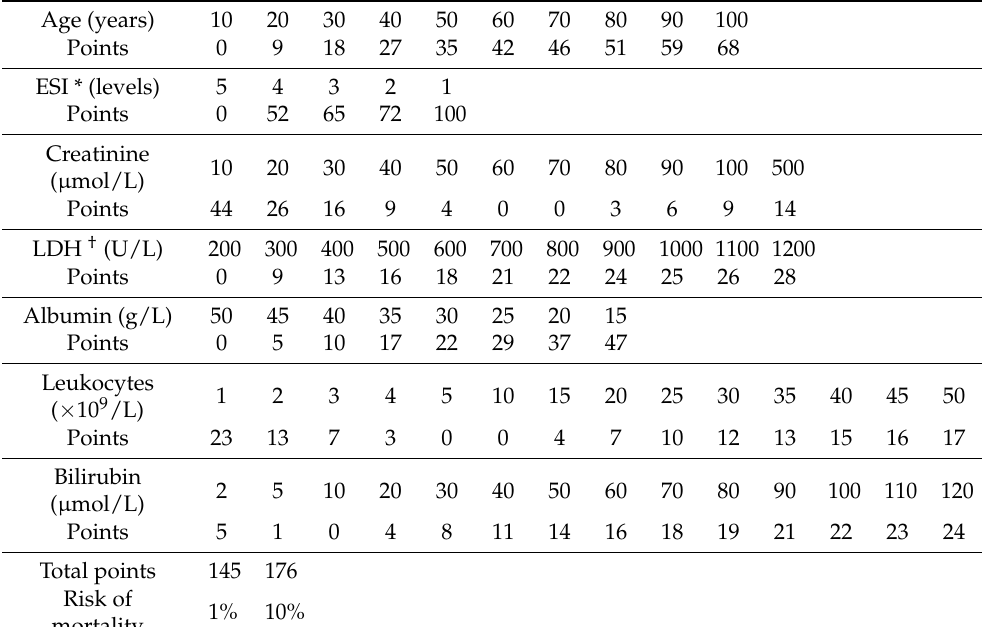
Table 3. TRIAL score for prediction of in ‐ hospital mortality.